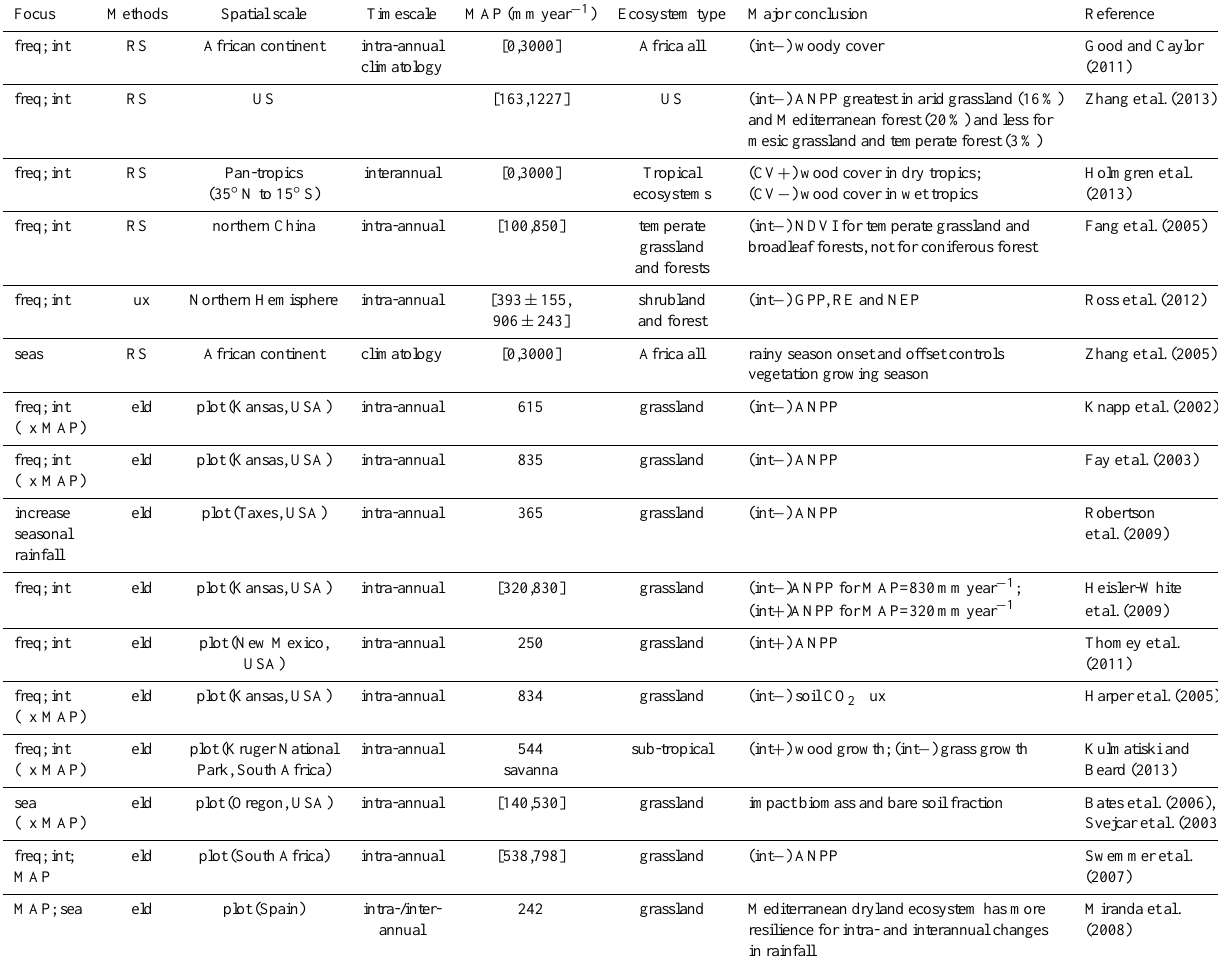
Table 1. Summary of previous representative studies on assessing the impacts of rainfall characteristics (i.e., rainfall frequency, intensity, and seasonality) on the structure and function of terrestrial